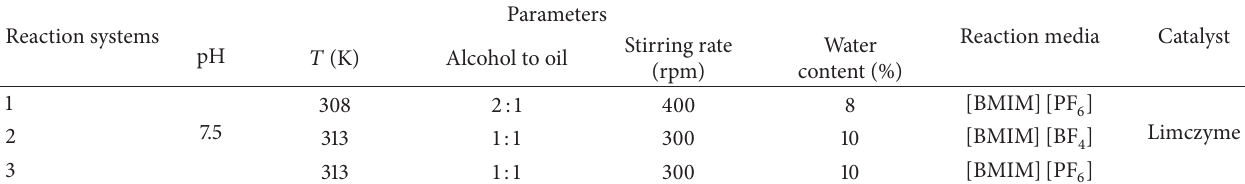
Table 1: Process parameters of different reaction systems of producing FAMEs catalyzed by